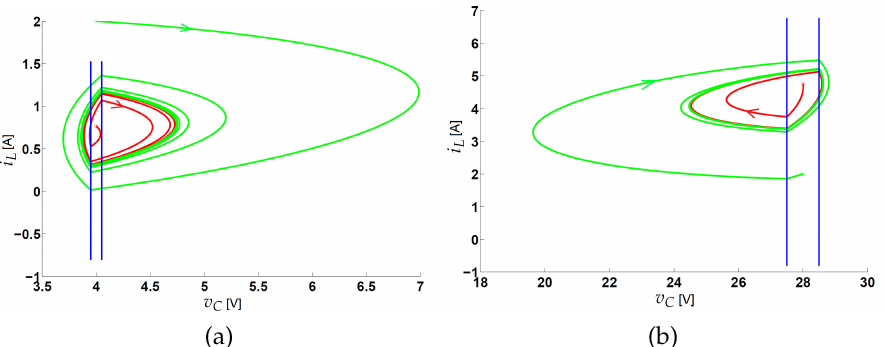
Figure 15. Voltage control using the constant hysteresis control for ξ = 0.2 V: ( a ) phase portrait and ( b ) time evolution.